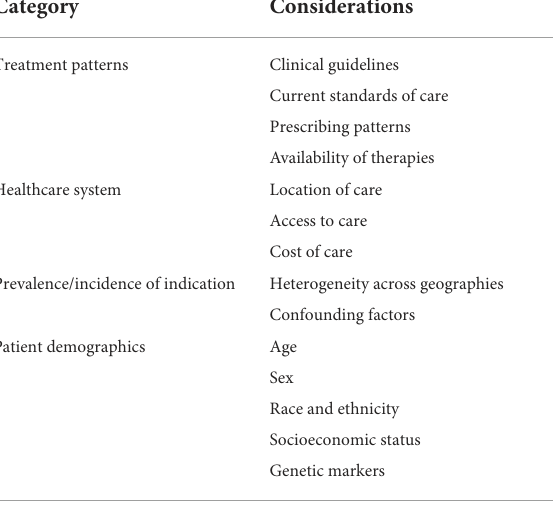
TABLE 2 Considerations for researchers to keep in mind for the transferability of